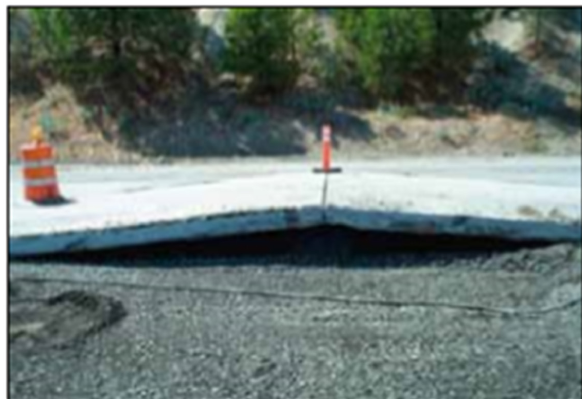
Figure 2: Concrete slab splitting off in the US [10]